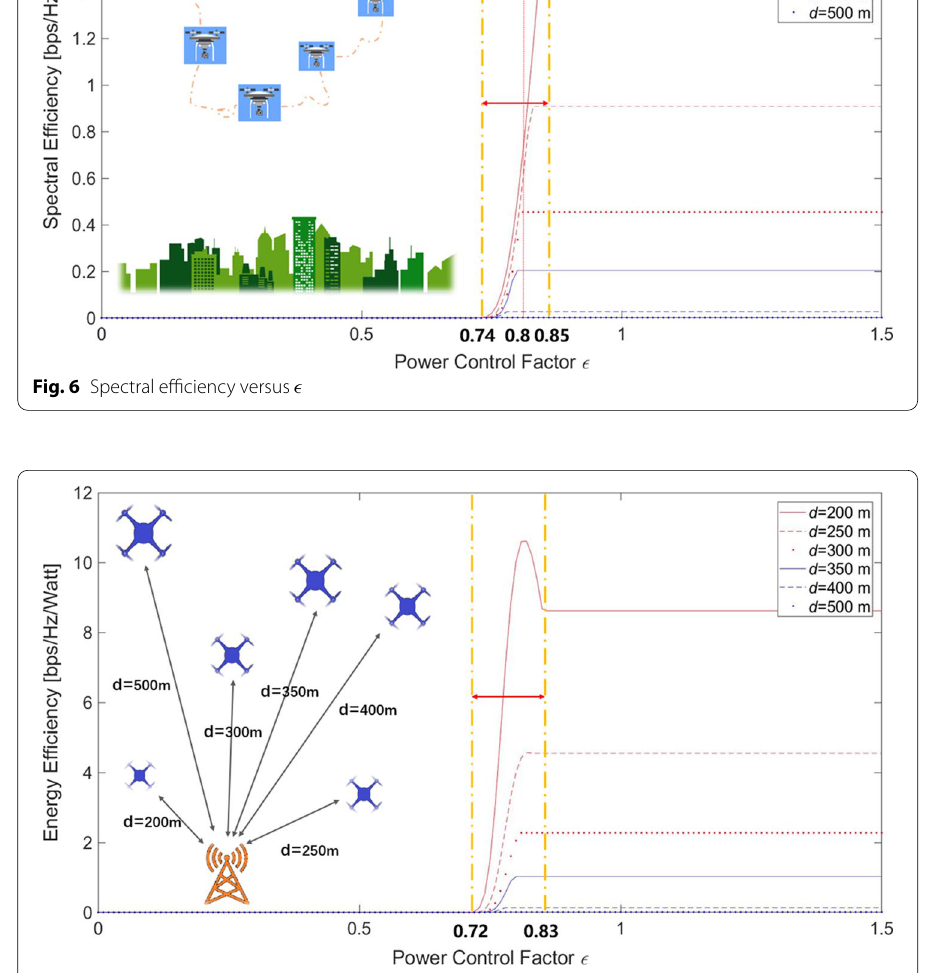
Fig. 7 Communication energy efficiency versus